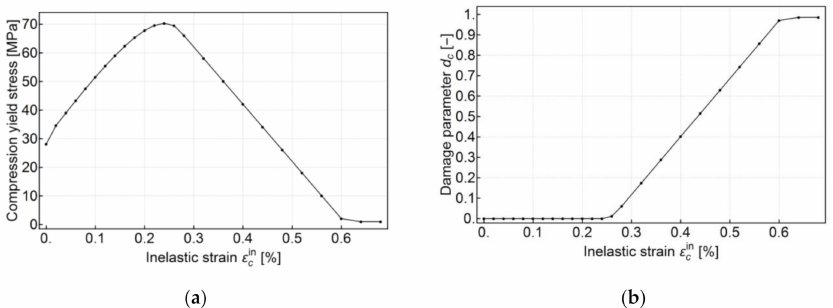
compressive behavior outside the elastic range defined as a tabular function of inelastic (or crushing) strain ε in c ( b ) uniaxial compression damage variable d c as a tabular function of inelastic strain.